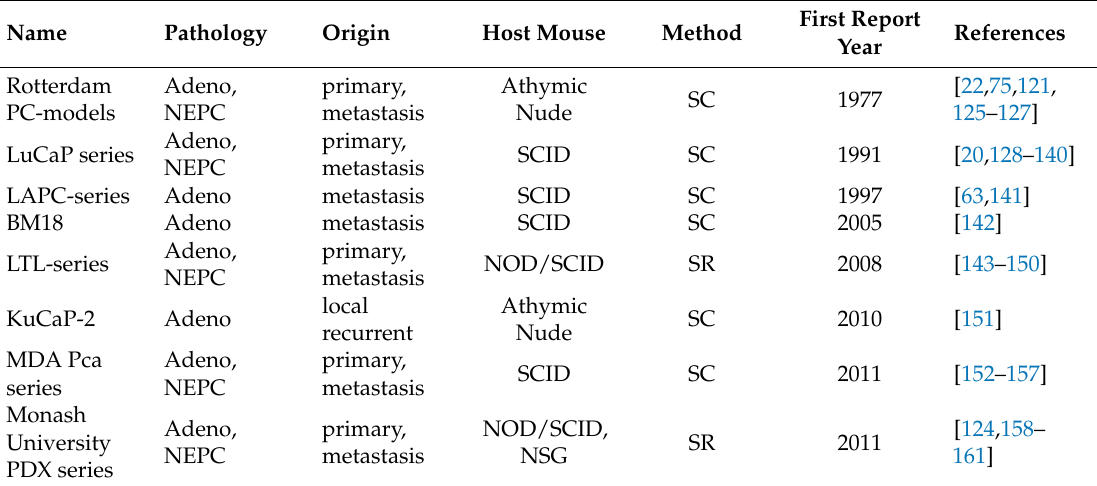
Table 3. Patient-derived xenografts of prostate